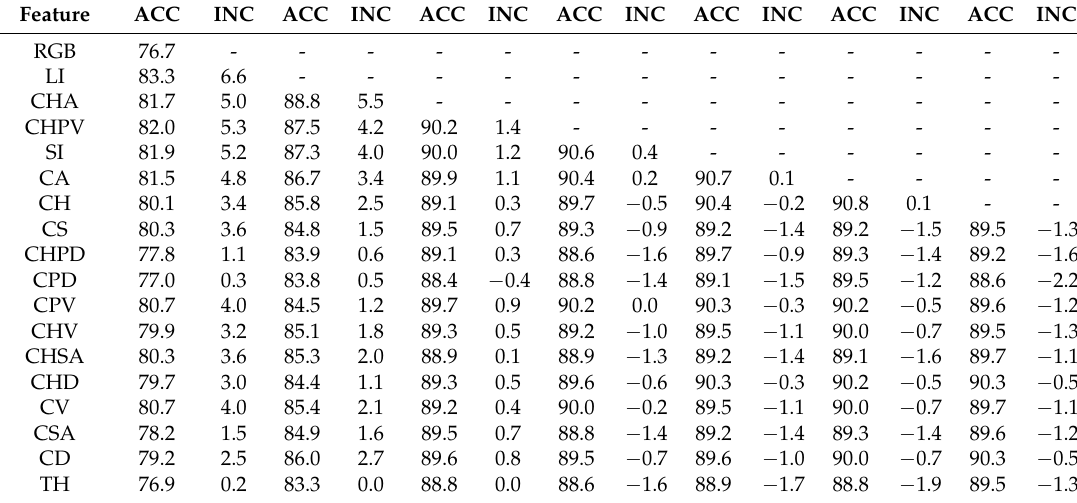
Table 4. Overall accuracy (%) of the quadratic SVM classifications using different features and increments compared to the highest accuracy in each previous loop. ACC, accuracy; INC, increment. The feature abbreviations are the same as in Table 2.